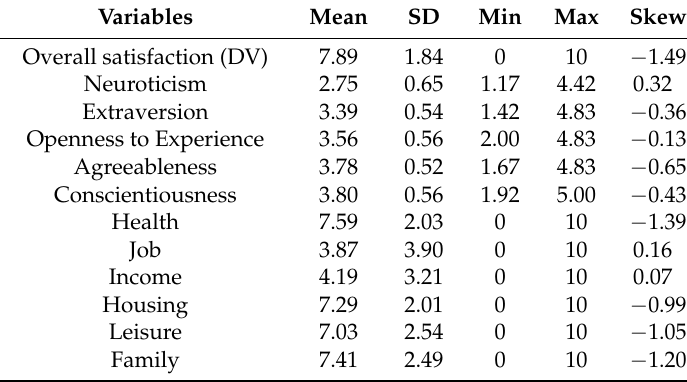
Table 7. Mean, standard deviation, minimum, maximum, and skew values of personality (NEO-FFI) and satisfaction variables for Survey 3; DV = Dependent variable. ( N = 496).